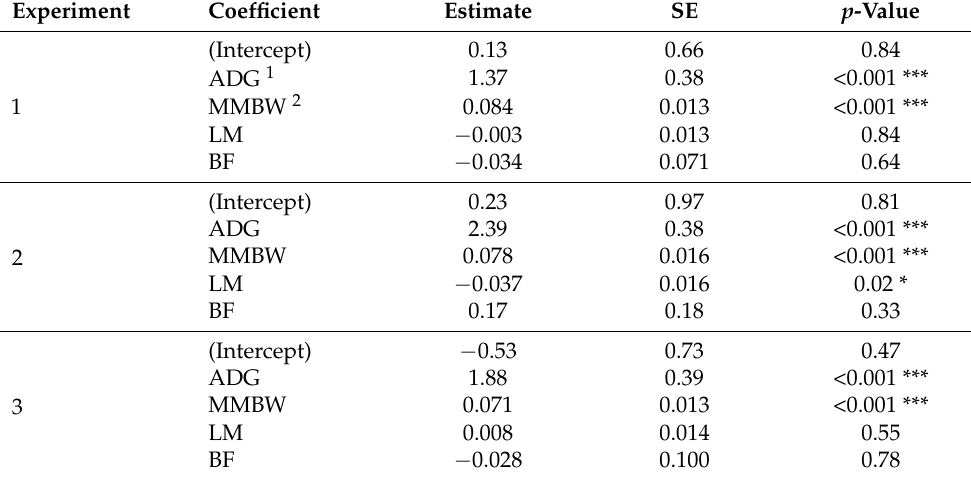
Table 5. Estimates, standard errors (SE), and p -values for the regression coefficients with a full model including all measured variables. The sub-cutaneous back fat thickness (BF, mm) and cross-sectional area of longissimus dorsi muscle (LM, cm 2 ) measurements are those measured at the end of the experiment since those values were available for all three experiments. For experiments 2 and 3, the model was also fitted using the average BF and LM values. The results were largely the same, except that the p -value of BF in experiment 2 was 0.04. Experiment Coefficient Estimate SE